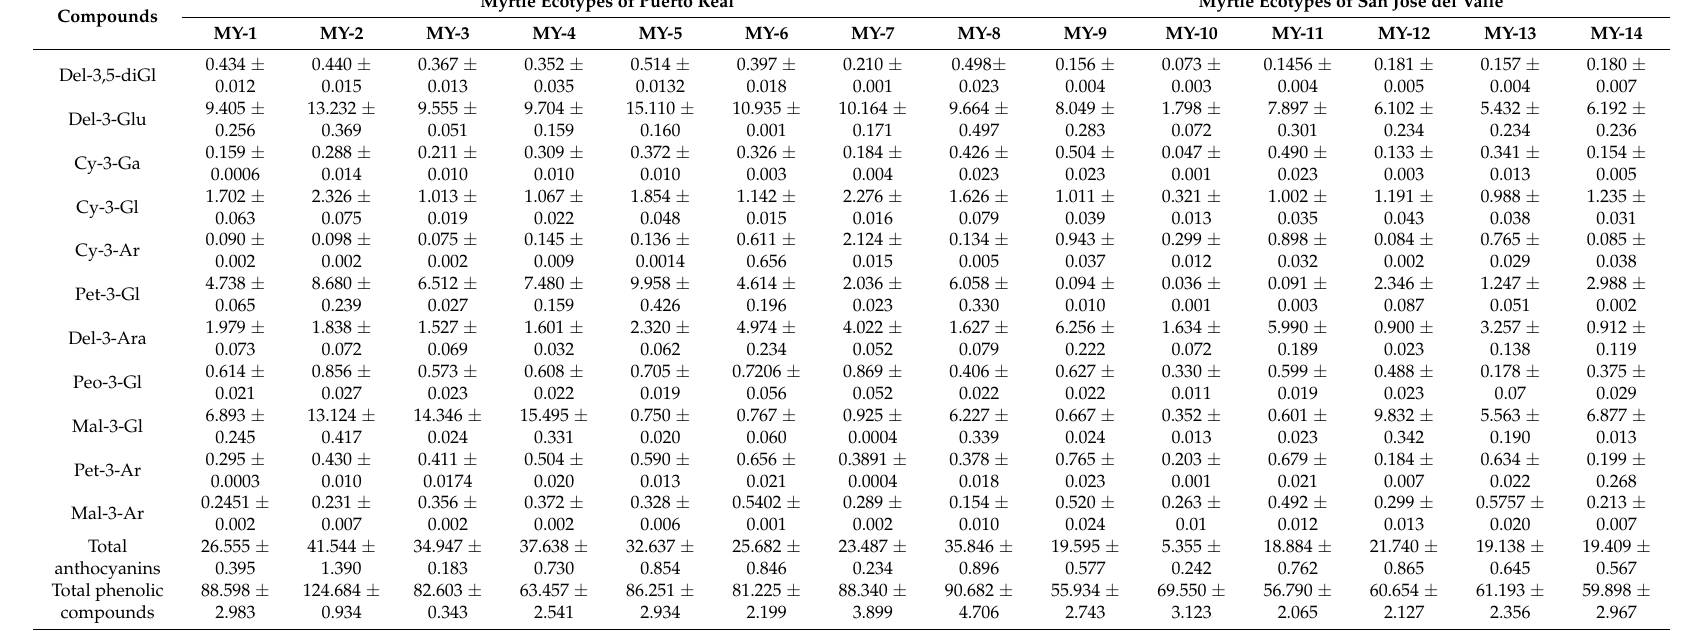
Table 3. Results of total phenolic compounds (mg g − 1 ) and total and individual anthocyanins (mg g − 1 ) for each myrtle ecotype ( n = 3). Del-3,5-diGl: